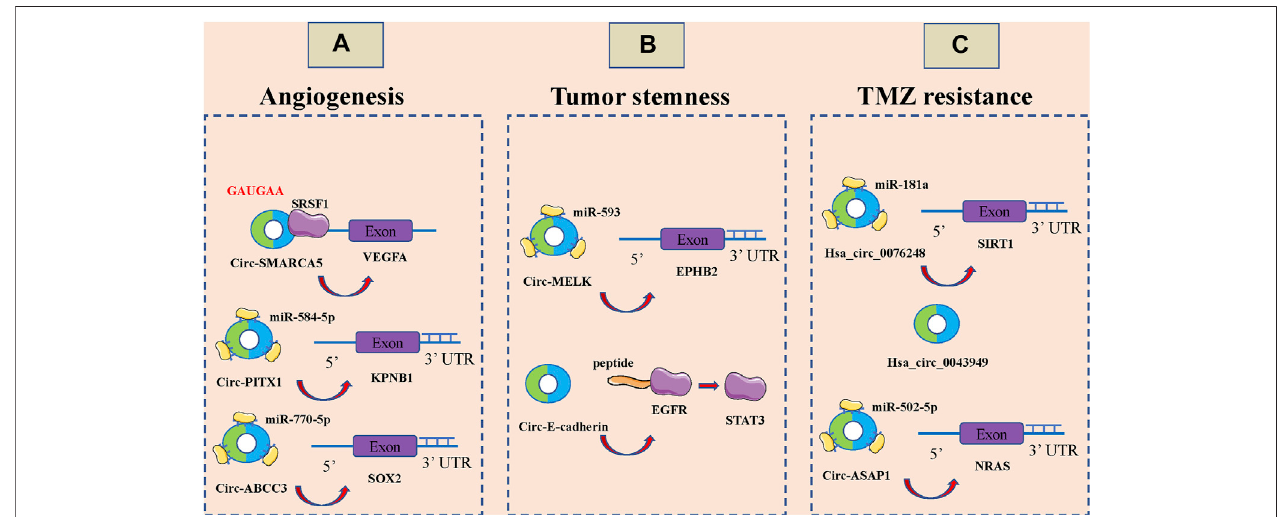
FIGURE 3 | CircRNAs associated with the angiogenesis, tumor stemness and temozolomide (TMZ) resistance of glioblastoma (GBM). (A) . CircRNAs associated withthe angiogenesis ofGBM, including circ-SMARCA5, circ-PITX1 and circ-ABCC3. (B) . CircRNAs associated with the tumor stemnessof GBM, including circ-MELK andcirc-E-cadherin. (C) :CircRNAsassociatedwiththetemozolomide(TMZ)resistanceofglioblastomaGBM,includinghsa_circ_0076248,hsa_circ_0043949andcirc- ASAP1.